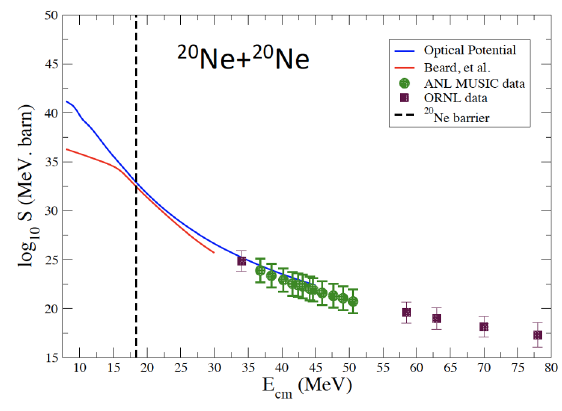
Figure 11. Comparison of the astrophysical S-factor prediction from Ref. [24] with experimental data.